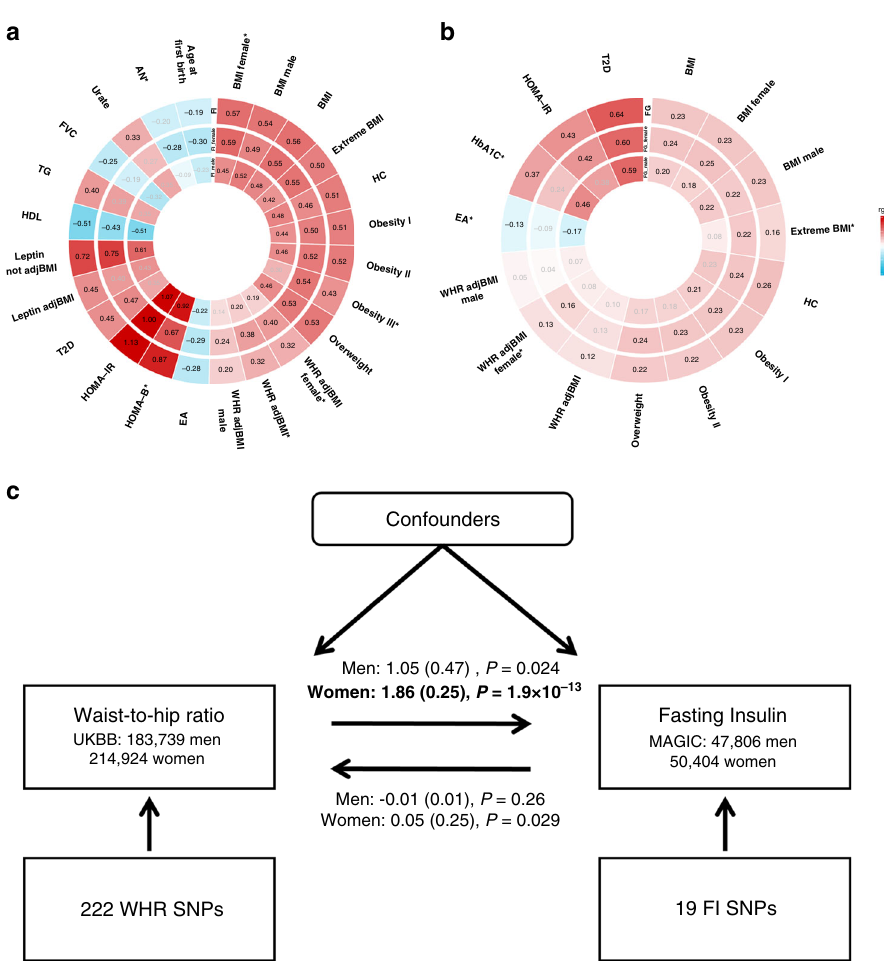
Fig. 3 Genetic correlations and causality. a Genetic correlations for FI, b genetic correlations for FG. Phenotypes with statistically signi fi cant ( P < 0.001) genetic correlations (calculated by LD score regression) with FI/FG in either women or men are plotted. The outer track shows estimates for all together, followed by those for women and men. Traits with I 2 (sex heterogeneity) ≥ 50% are labeled with asterisks. Gray color indicates traits that do not show signi fi cant genetic correlation with the given glycemic trait. Estimates in black color indicate statistically signi fi cant associations. c bi-directional MR analysis between WHRadjBMI and FI with betas, standard errors of the estimates and P values from random-effect inverse-variance weighted regression given for men and women. AN anorexia nervosa, BMI body-mass index, EA educational attainment as of years of schooling 2016, FVC forced vital capacity, HbA1c glycated hemoglobin, HC hip circumference, HDL high-density lipoprotein cholesterol, HOMA-B homeostatic model assessment of beta cell function, HOMA-IR homeostatic model assessment of insulin resistance, leptin adjBMI leptin adjusted for BMI, Leptin not adjBMI leptin not adjusted for BMI, Obesity 1 obesity class 1, Obesity II obesity class II, Obesity III obesity class 3, T2D type 2 diabetes, TG triglycerides, WC waist circumference, WHR adjBMI waist-to-hip ratio adjusted for BMI, UKBB UK Biobank.